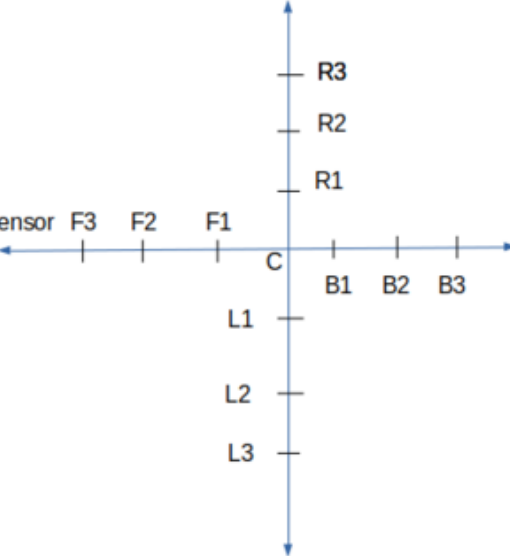
Figure 11. Data collection for dynamic activities. Ri represents point right , Li represents point left, Bi represents point backward and Fi represents points forward with respect to the